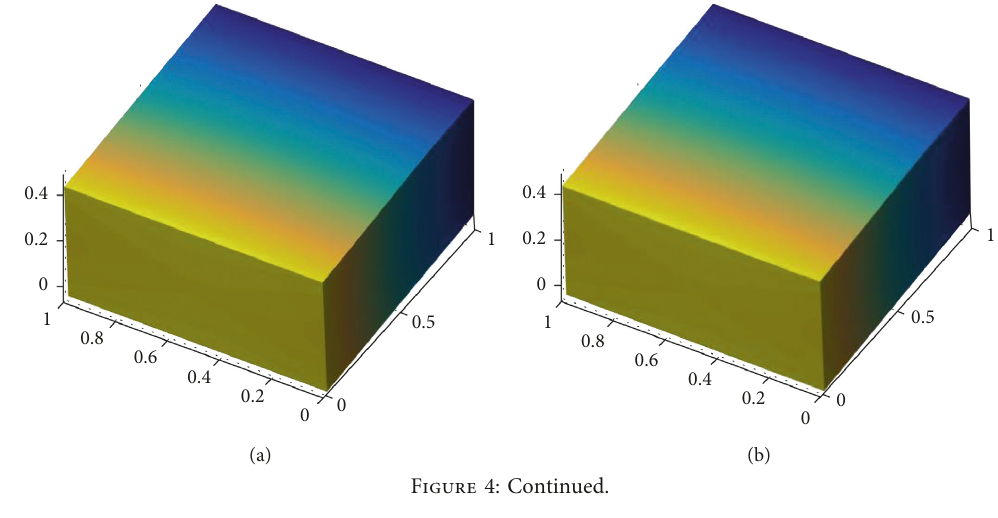
Figure 3: Mode shapes of the elastically supported plate elastically restrained in the y direction: (a) k (d) k v � 10 16